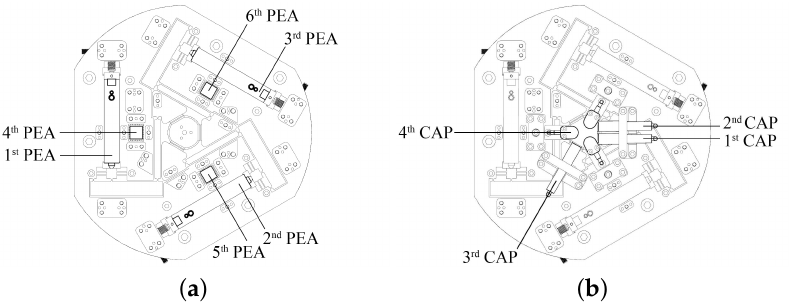
Figure 6. A 6-RRRR CPM, actuators and sensors to build a 6-RRRR NPS. ( a ) Six piezoelectric actuators; ( b ) four capacitive sensors.